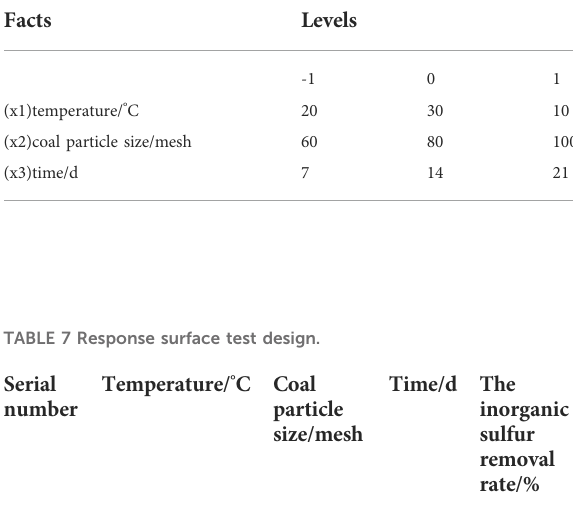
TABLE 8 Signi fi cance test of regression model. TABLE 6 Response surface factor level code.